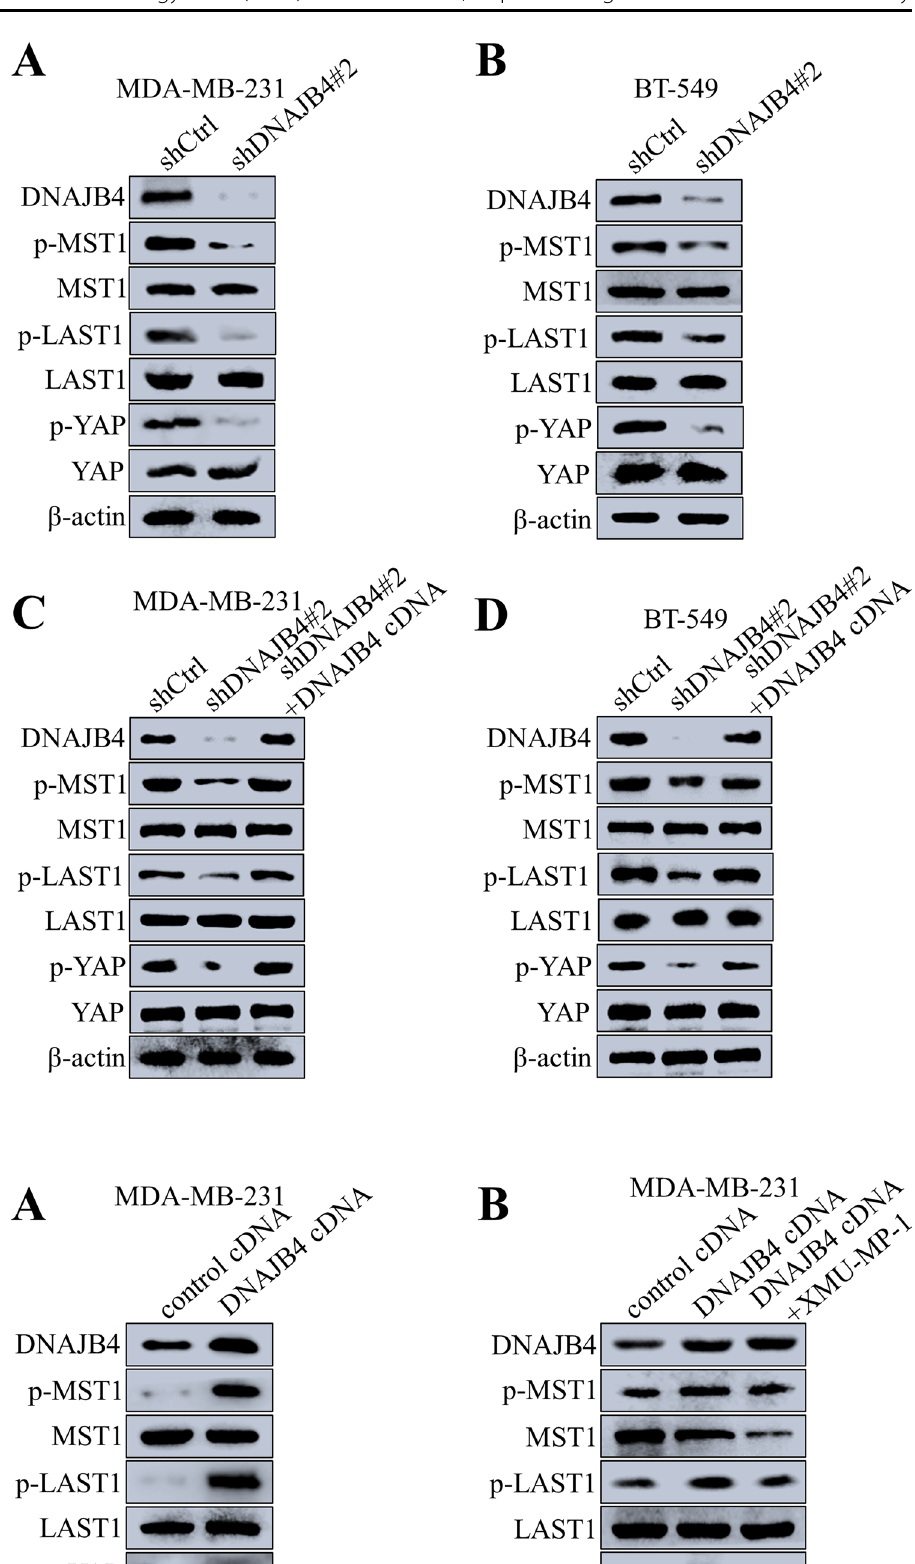
Fig. 6 DNAJB4 promotes TNBC cell apoptosis via activating the Hippo signal- ing pathways. A Changes of Hippo signaling pathway- related proteins after DNAJB4 overexpression in MDA- MB-231 cell, determined by western blot. β-actin was used as a loading control. B Changes of Hippo signaling pathway-related proteins in DNAJB4 overexpressed MDA- MB-231 cells after the addition of XMU-MP-1, an inhibitor of MST1, determined by western blot. β-actin was used as a loading